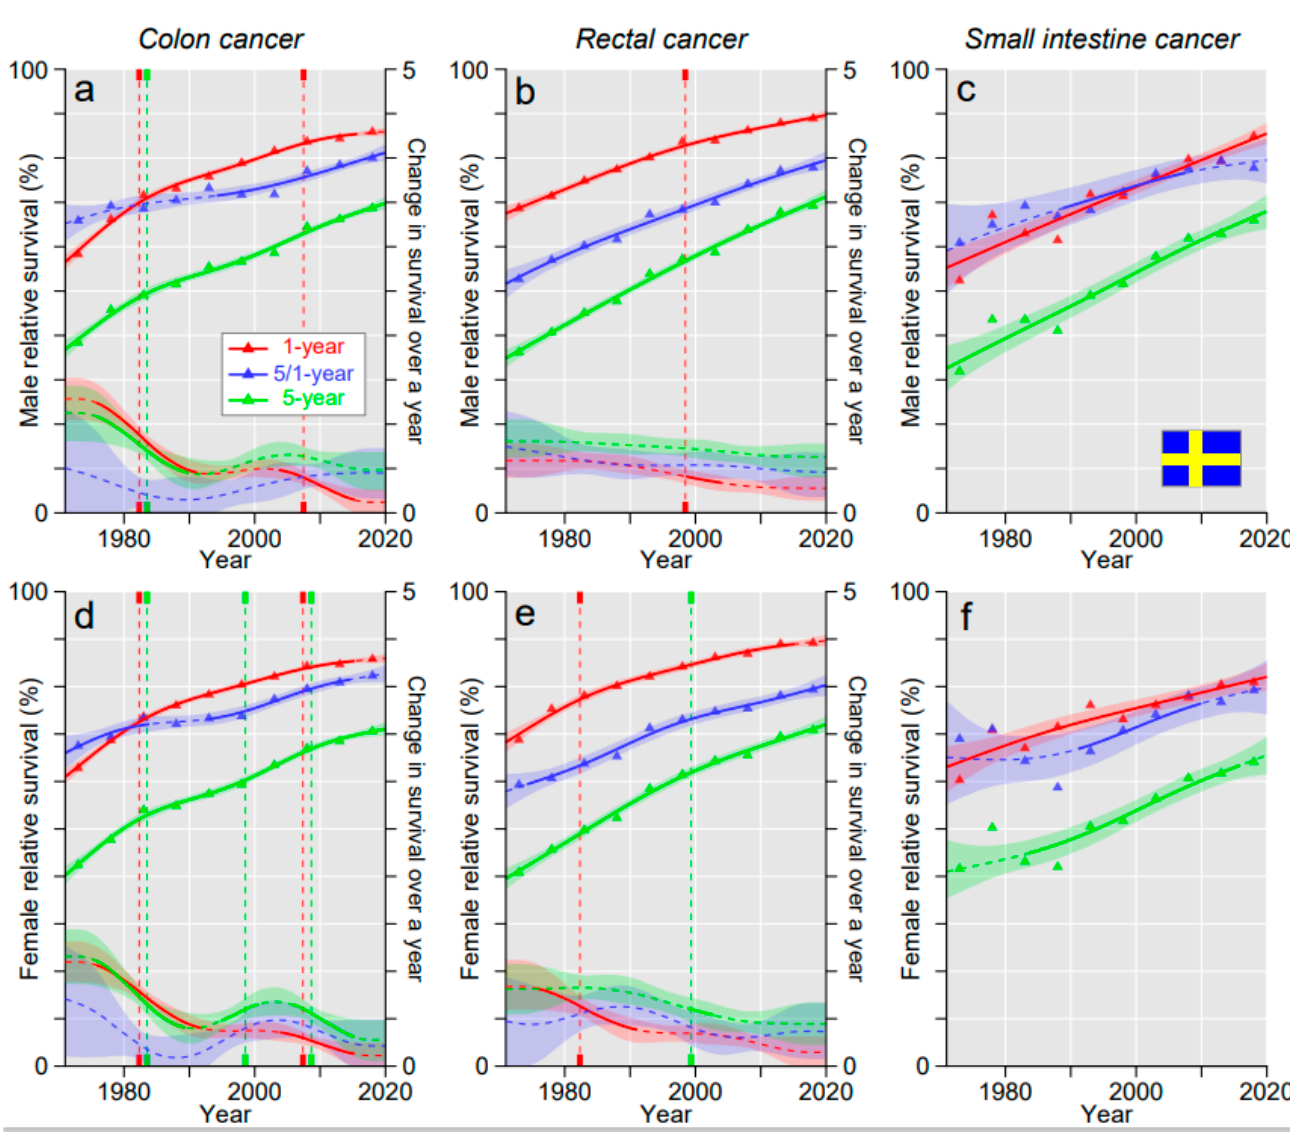
Figure 4. Relative 1- , 5/1- and 5-year survival in Swedish men ( a – c ) and women ( d – f ) in colon ( a , d ), rectal ( b , e ) and small intestinal cancers ( c , f ). The vertical lines show significant breakpoints in survival trends and bottom curves show estimated annual changes in survival. The solid lines in survival curves and annual change curve indicate a plausible trend (see Methods). All curves are color coded (see the insert).